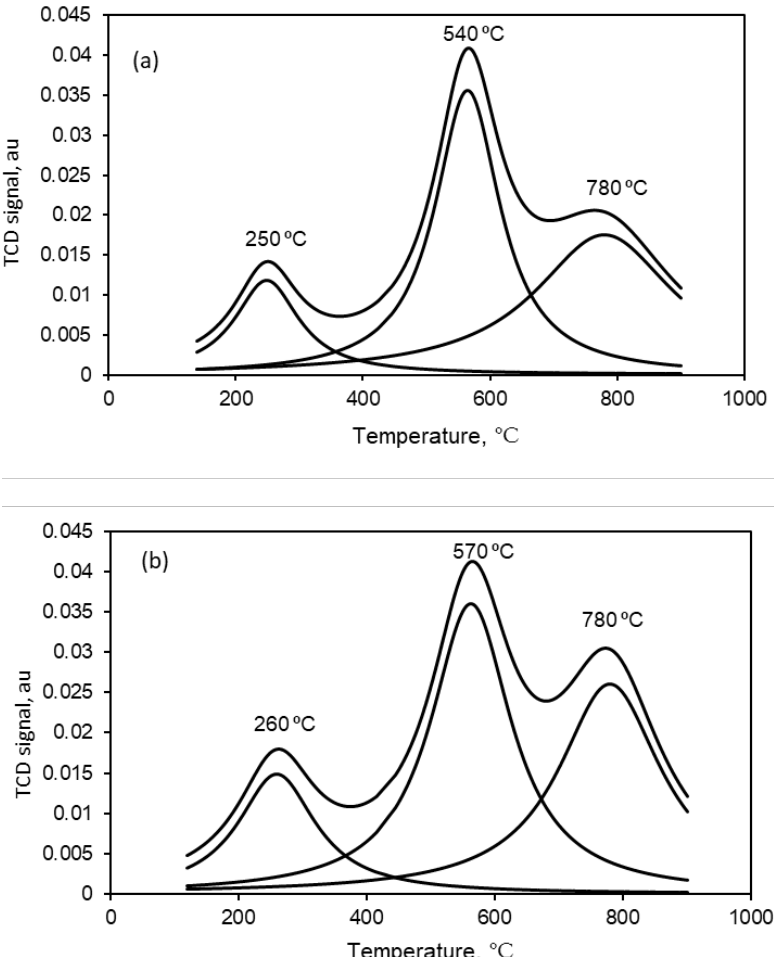
Figure 3. Ammonia TPD profiles of CAT-B before ( a ) and after ( b ) the dehydrogenation reaction. Table 2. Physico-chemical properties of catalysts before and after dehydrogenation of H18-DBT, including the quantity of carbon impurities.